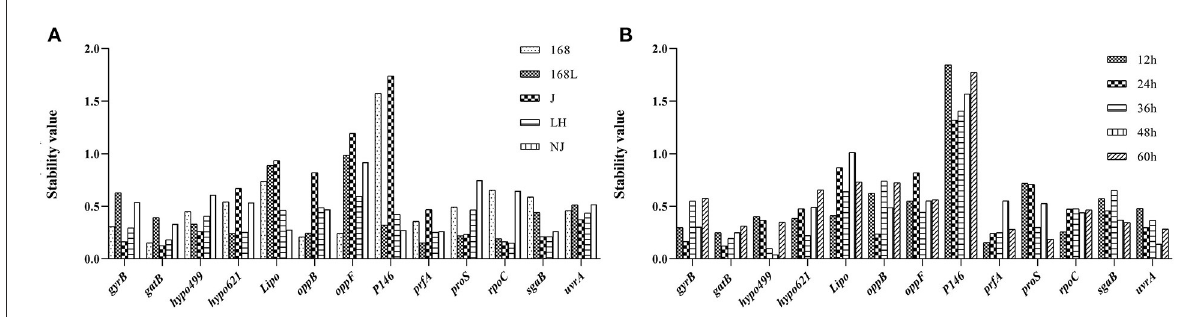
FIGURE4 Stability analysis of internal reference genes using the NormFinder software. The x-axis represents various candidate reference genes. The y-axis represents stability value. (A) : stability value of reference gene of the same strain at different culture time. (B) : stability value of reference gene of different strains at the same culture